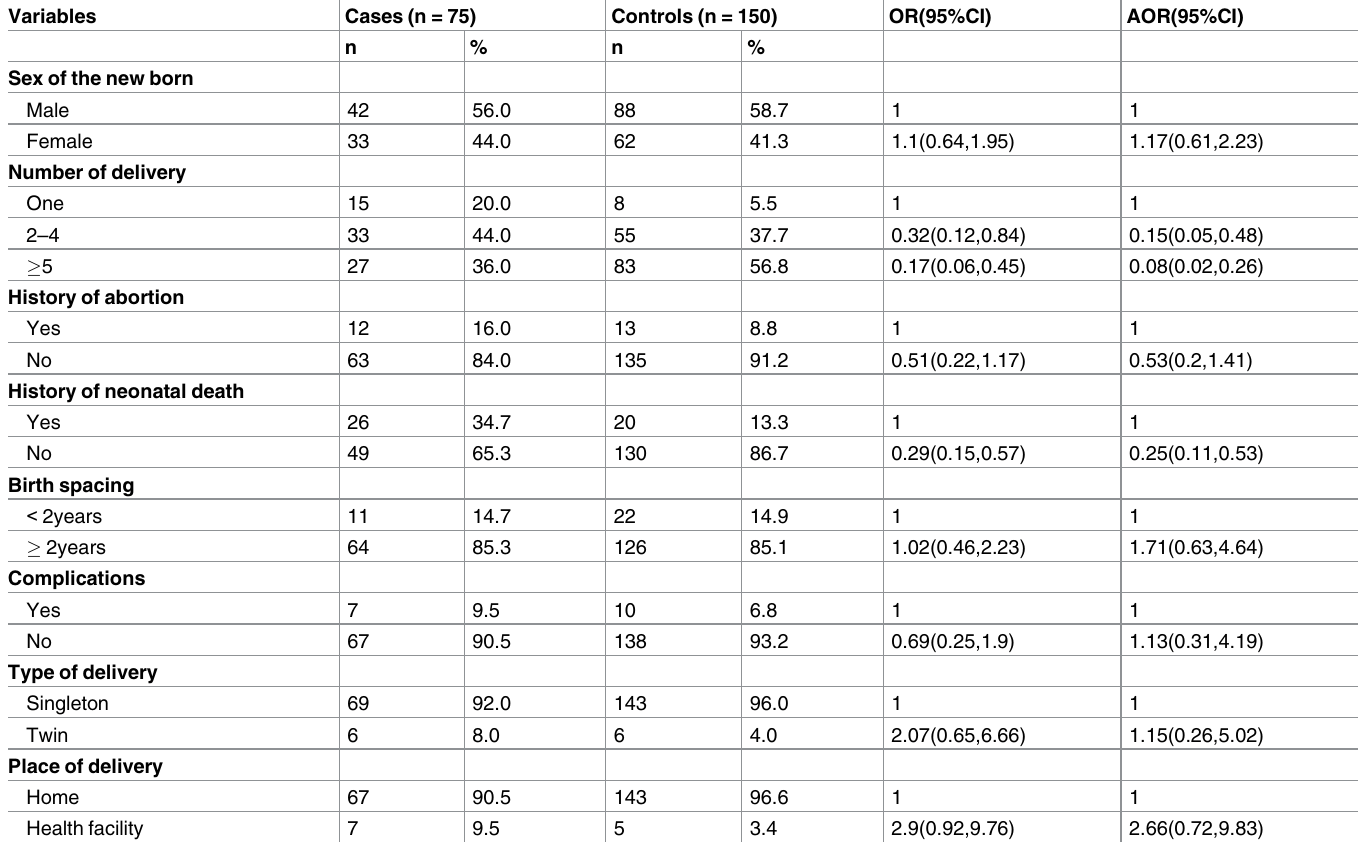
Table 4. Present and past obstetric condition related variables and neonatal mortality in West Gojam zone, Ethiopia Feb 2012(n =